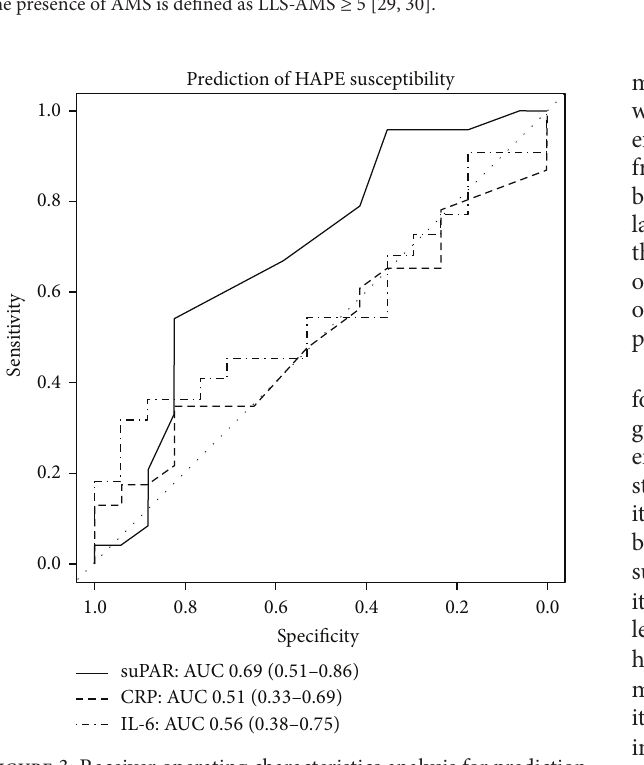
Figure 3: Receiver operating characteristics analysis for prediction of high altitude illness versus control group assignment by baseline measurements. AUC: area under the curve; in parentheses: 95% confidence